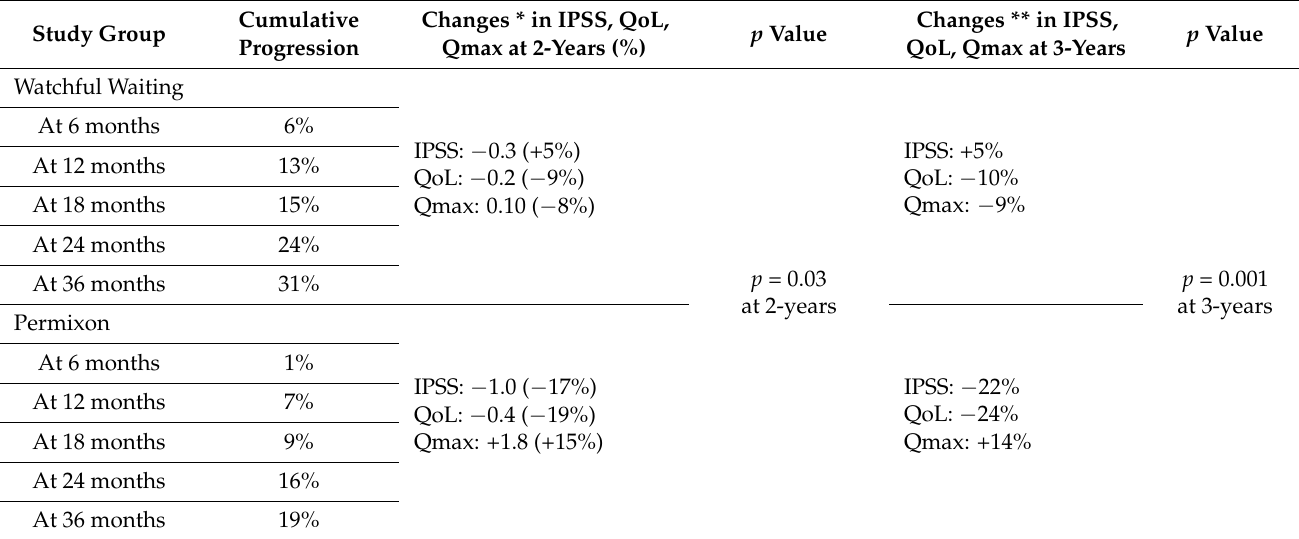
Table 3. Delay in the progression of LUTS/BPH with Permixon vs. Watchful Waiting (adapted from Djavan [35]. Permixon showed a statistically significant delay in progression at 2 and 3 years. Progression was defined as change from mild IPSS (1–7) to moderate (8–18) or severe IPSS (>18), or to the occurrence of surgical intervention. The “net” benefits of Permixon over Watchful Waiting were IPSS improvement of 27%, QoL improvement of 34%, and Qmax improvement of